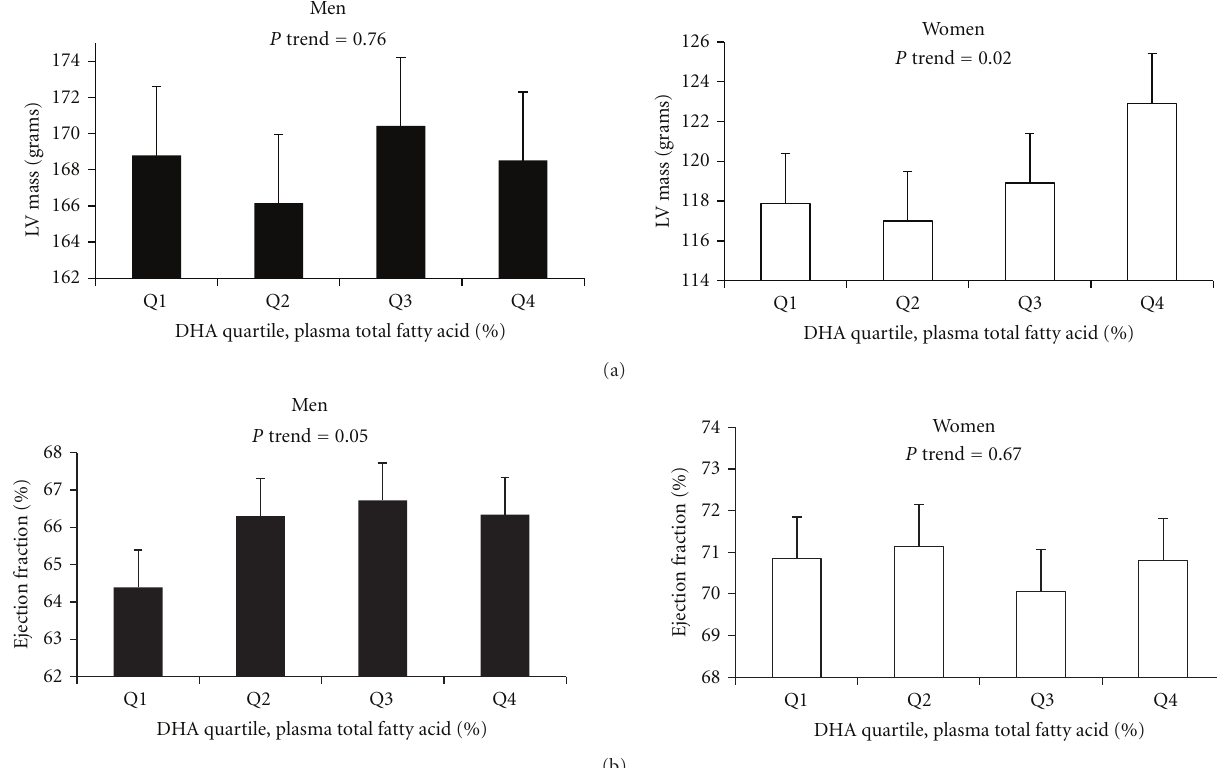
Figure 1: Relations between plasma phospholipid docosahexaenoic acid (DHA) levels, left ventricular (LV) mass, and ejection fraction, by gender. Results shown are least squares means ± SD after adjustment for age, race/ethnicity, BMI, current smoking status, education level, site, total:HDL cholesterol, systolic blood pressure, and total energy intake. Concentrations of plasma phospholipid fatty acid levels (expressed as percentages of total fatty acids) including DHA were summed and ranked into quartiles from lowest to highest based on sample range. Significant gender × DHA interactions were noted for both LV mass ( P = 0 . 003) and ejection fraction ( P = 0 .